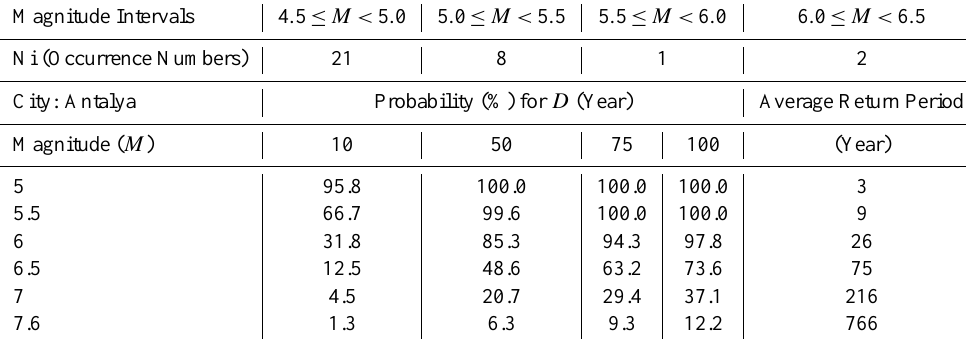
Table 3c. Earthquake occurrence probability (%) for D (Year) for Antalya city.